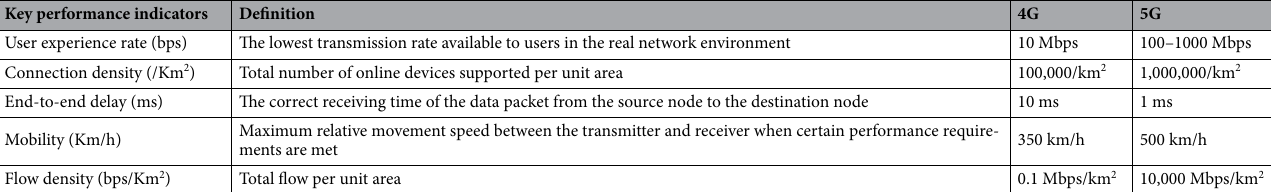
Table 1. Comparisons of key performance indicators between 5 and